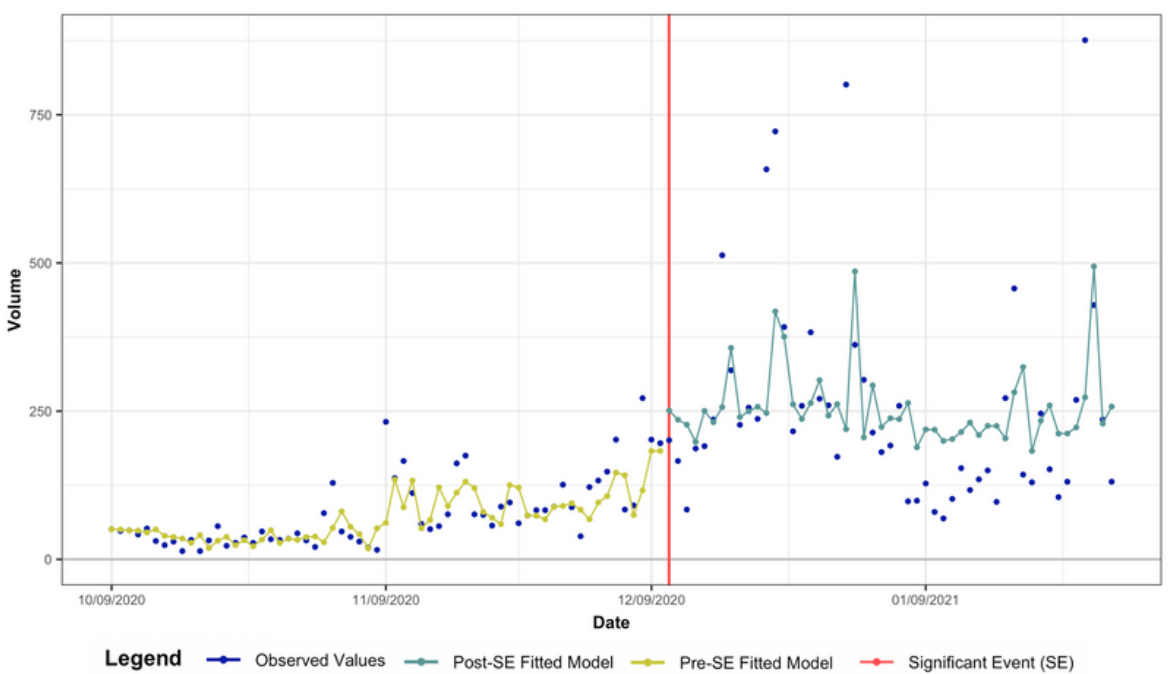
Figure 2. Plot of ARIMA Models before and after vaccine approval. From